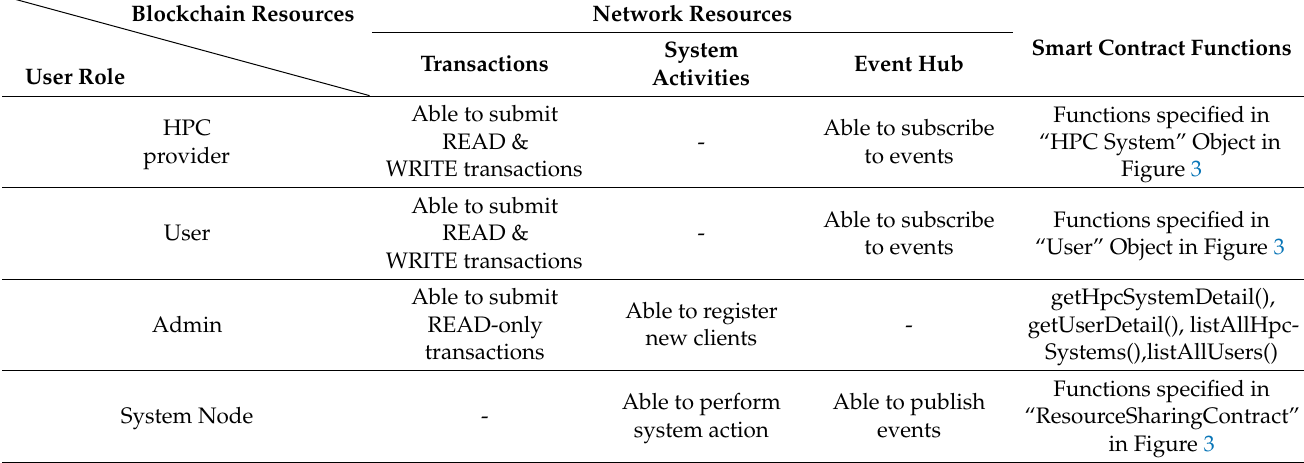
Table 1. Permission on Network Resources and Smart Contract Functions Based on User’s Role.